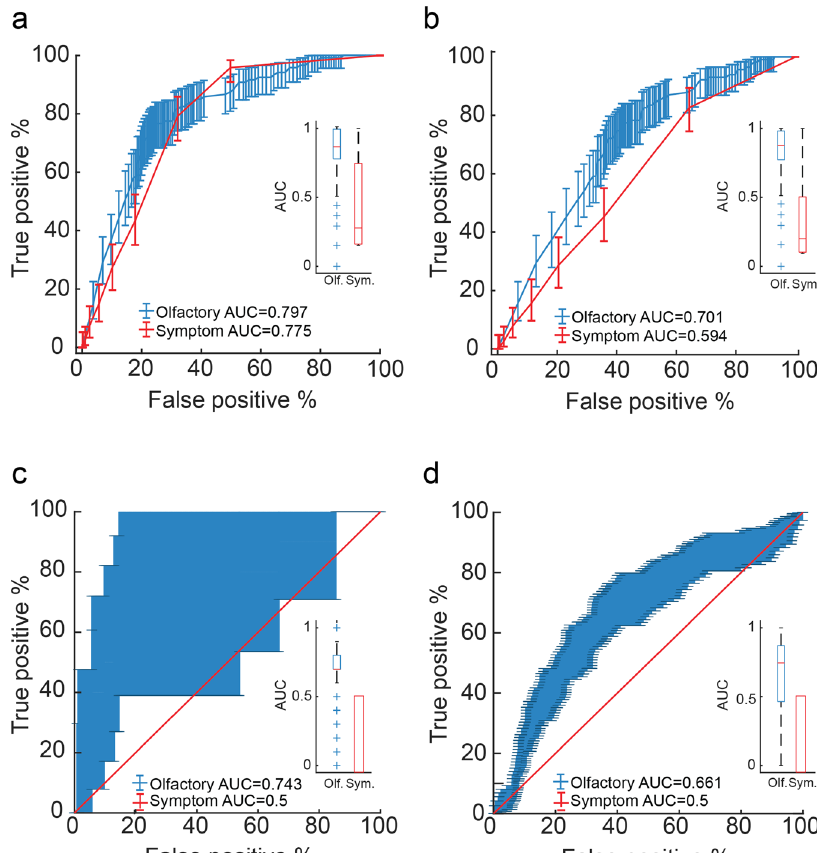
Fig. 5 Olfactory testing is more effective than symptom checking. a Receiver-operator curves (ROCs) for all participants who smelled Olive Oil ( n = 5167 participants), based on odor intensity (blue) or reported symptoms (red). For all panels: the inlay re fl ects mean ROC area under the curve (AUC). The central mark in the box indicates the median. Bottom and top edges of the box indicate the 25th and 75th percentiles, respectively. The whiskers extend to the most extreme data points not considered outliers. Outliers are plotted individually using the “ + ” symbol. b ROCs for all participants who smelled Olive Oil and had symptoms ( n = 2627 participants), based on odor intensity (blue) or reported symptoms (red). c ROCs for all asymptomatic participants ( n = 7740 participants), based on a classi fi er using OPFs (blue) or reported symptoms (red). We note no variance in the symptom-based box (red) as all participants were asymptomatic. d Same as in c , but for a later-collected independent set of 1464 participants, with a signi fi cantly higher proportion of C19 + . Note that the reported symptoms have zero variance in c and d because these are all completely asymptomatic participants. The difference in variability between c and d is because c has 33 asymptomatic C19 + participants, yet d has 114 asymptomatic C19 +